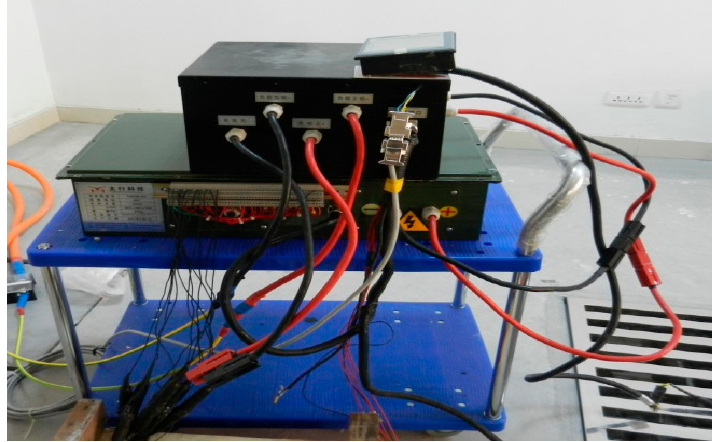
Figure 4. Experimental battery pack.